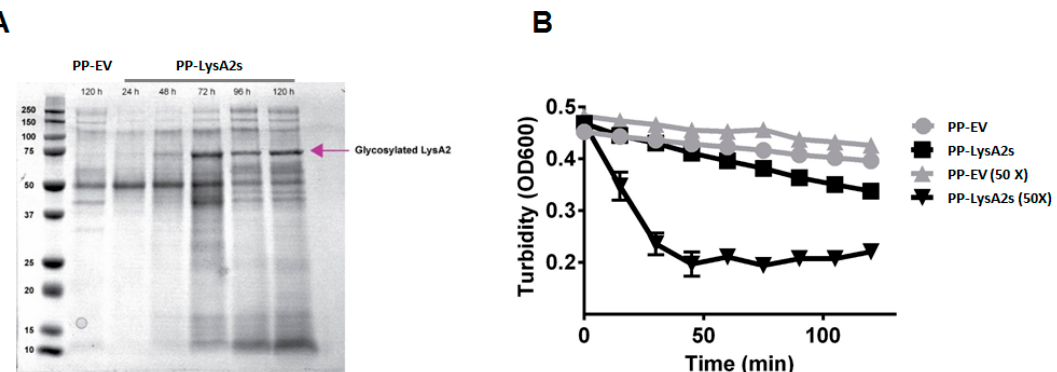
Figure 2. Activity of supernatant containing secreted LysA2 from P. pastoris. Secreted LysA2 from P. pastoris (PP-LysA2s) was confirmed by SDS-PAGE analysis of the supernatant. The LysA2 in the supernatant increased with increased incubation time. The molecular weight (~72 kDa) was larger than the expected size (42 kDa) which could be due to glycosylation ( A ). Lytic activity was confirmed by turbidity reduction with L. casei treated with concentrated (50 × ) and unconcentrated culture supernatant from the P. pastoris secreting LysA2 strain (PP-LysA2s) compared to the culture supernatant from the P. pastoris with the empty vector strain (PP-EV) ( B ). Viruses 2018 , 10 , x FOR PEER REVIEW